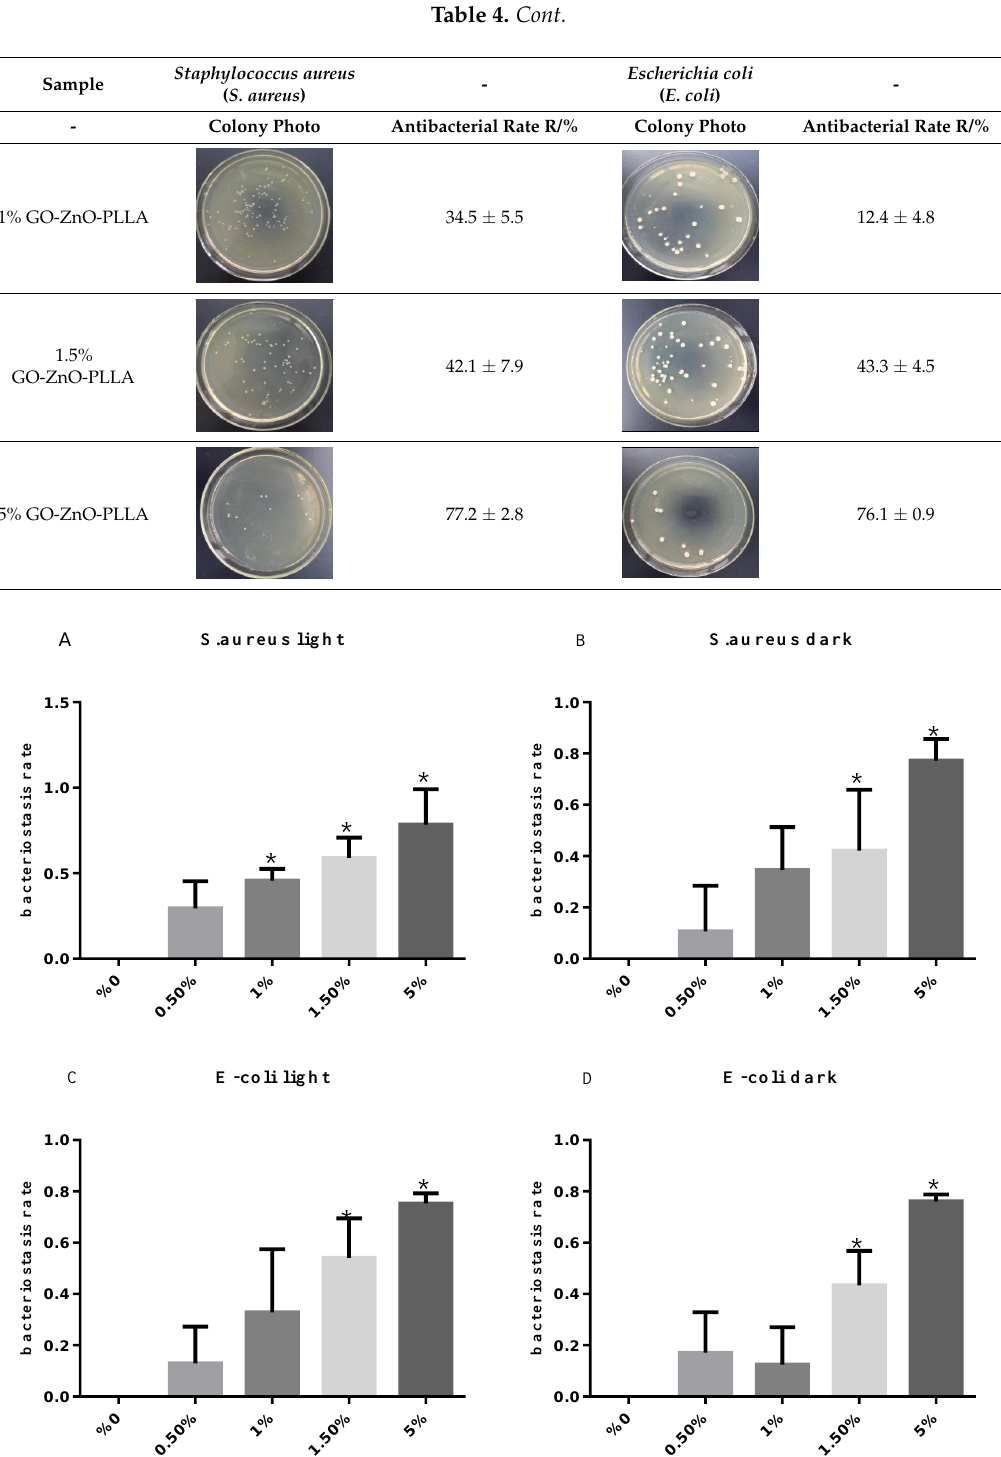
Figure 13. Statistical plots of the antibacterial rates of ( A ) inhibition of samples against S. aureus under light exposure, ( B ) inhibition of samples against E. coli under light exposure, ( C ) inhibition of samples against S. aureus without light exposure, and ( D ) inhibition of samples against E. coli without light exposure. * indicates a significant difference with 0% (PLLA), p < 0.05.